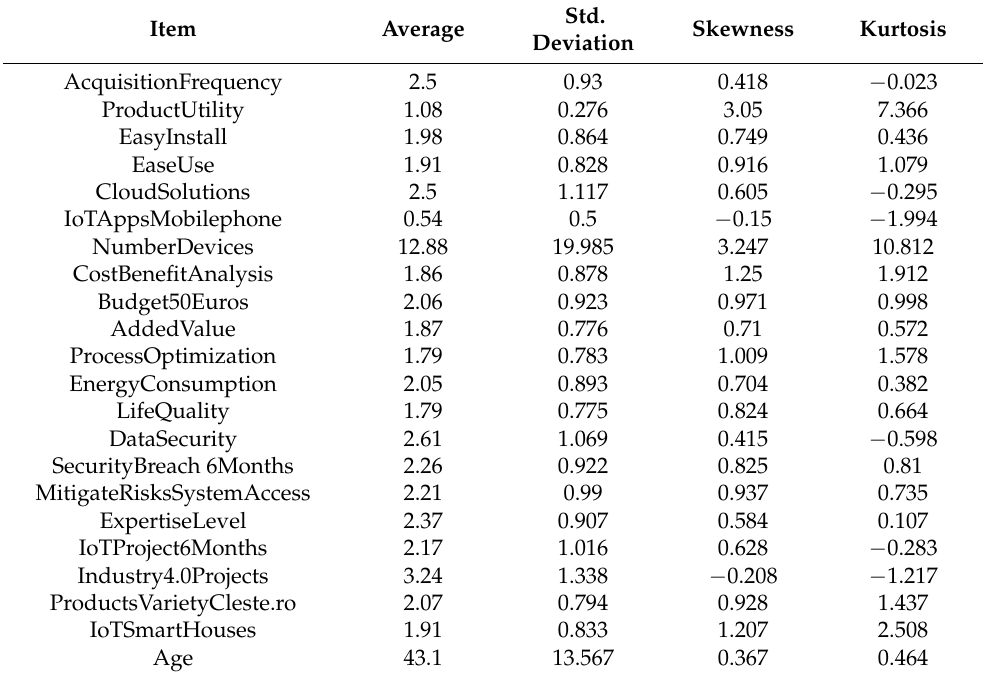
Table 2. Descriptive analysis using SPSS ( n = 242).